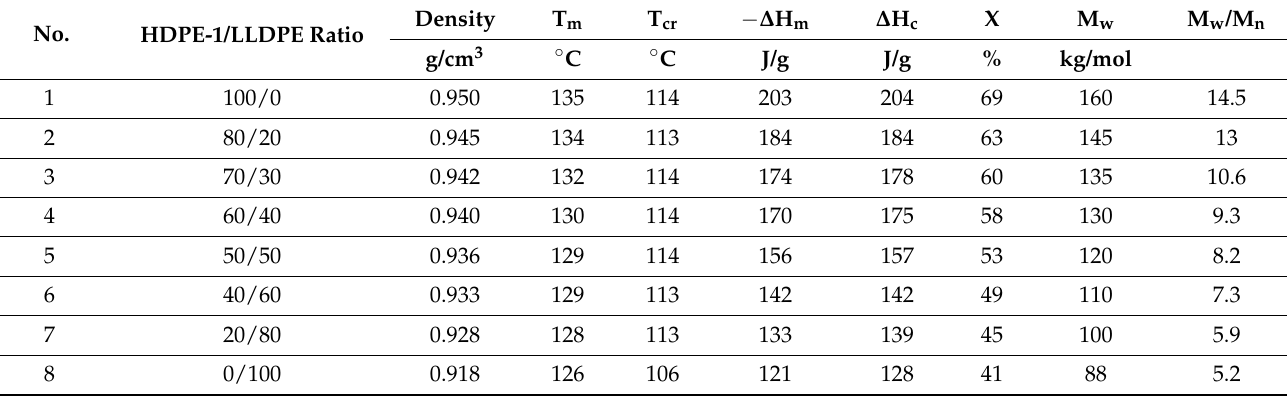
Table 3. The influence of LLDPE on density, molecular characteristics, and thermal properties of the compositions.